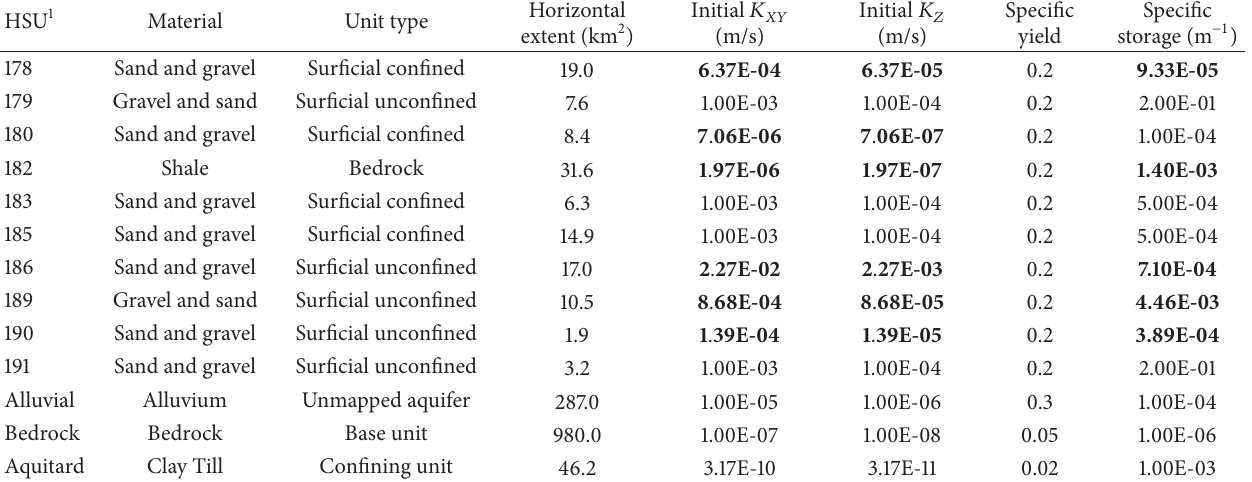
Table 3: Saturated zone initial hydraulic